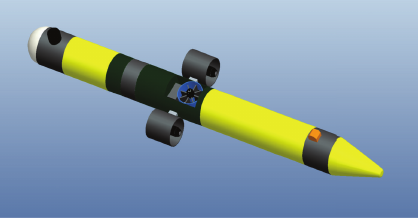
Figure 1: Minesniper MkII.